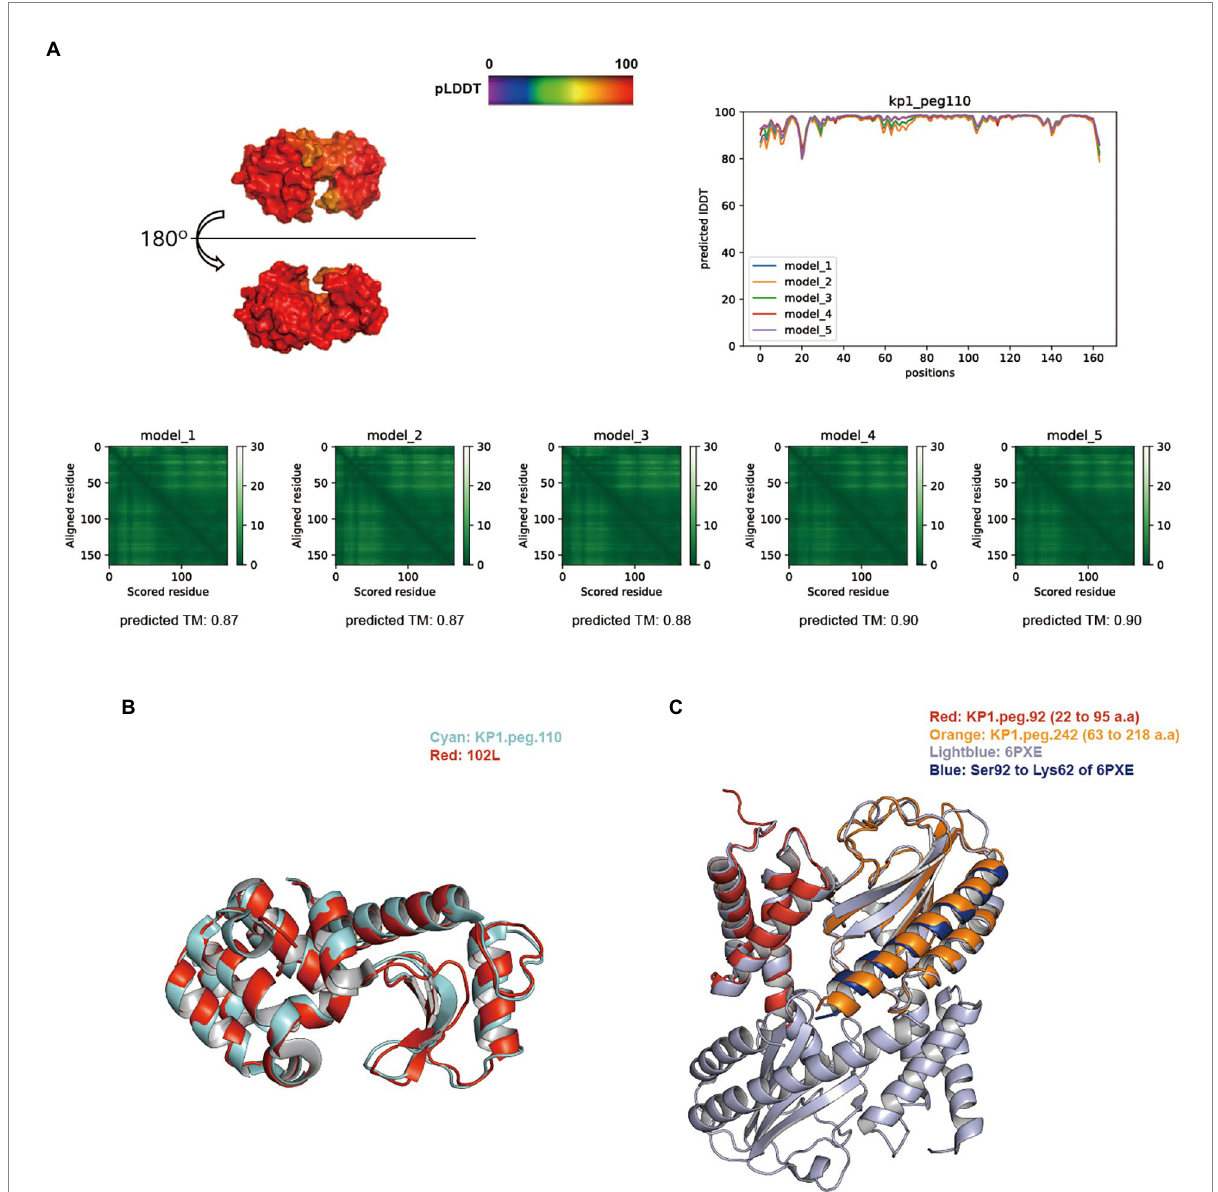
FIGURE 5 Structure prediction of putative host-lytic proteins in KP1 and their alignments with X-ray crystal structures. (A) AlphaFold models generated for KP1.peg.110 show high pLDDT and predicted TM-scores. Protein surface structure of the first pTM model (model_1; top left), and its corresponding 2D plot showing the score for amino acid at each position (top right) are color-coded according to its pLDDT. PAE heatmaps of five models and their pTM scores illustrate the predicted error between all pairs of residues. The lower value (darker green) indicates higher confidence in the prediction. (B) Structural alignment of the KP1.peg.110 model (cyan) to T4 endolysin E X-ray crystal structure (PDB ID: 102 l, red). (C) Structural alignment of the partial KP1.peg.92 (putative anti-holin, residue 22–95, red) and the partial KP1.peg.242 (putative holin, residue 63–218, orange) to T4 RI-T complex crystal structure (PDB ID: 6PXE, light blue). The continuous helix from Ser92 to Lys62 of 6PXE is colored